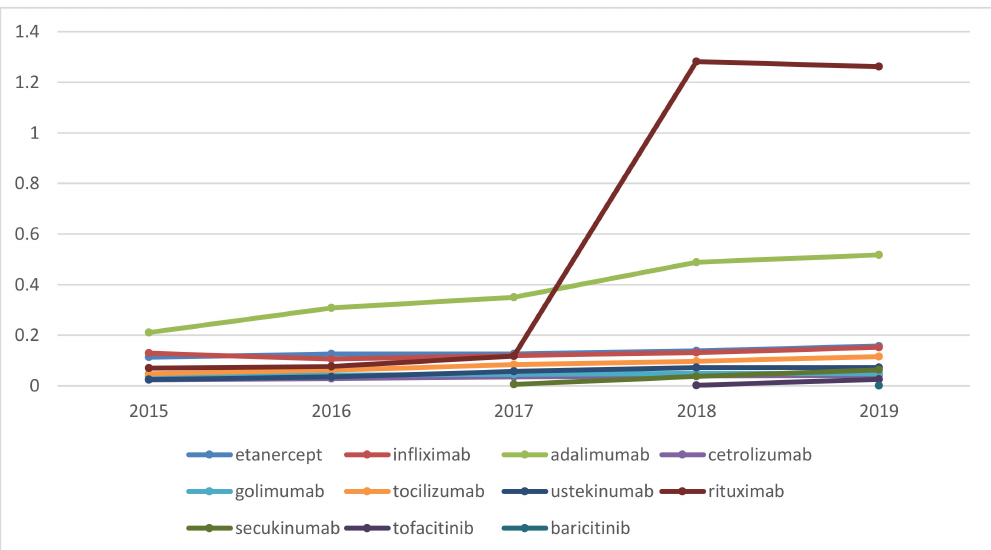
Figure 2. Utilization in